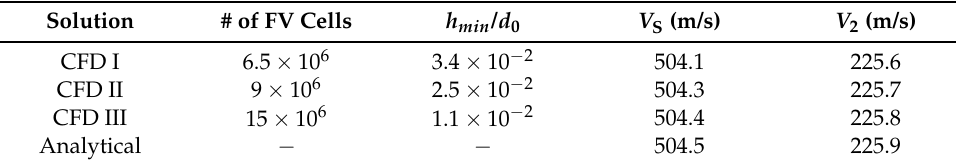
Table 4. Shock tube flow: traveling velocities for different mesh resolutions.